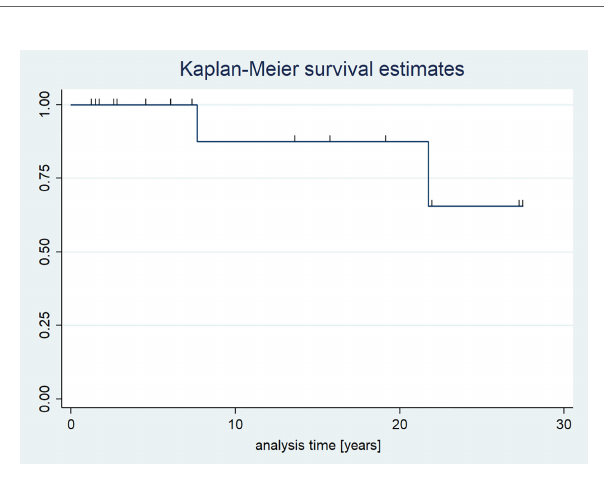
FIGURE 6 | Kaplan-Meier survival curves in children with GCTs.